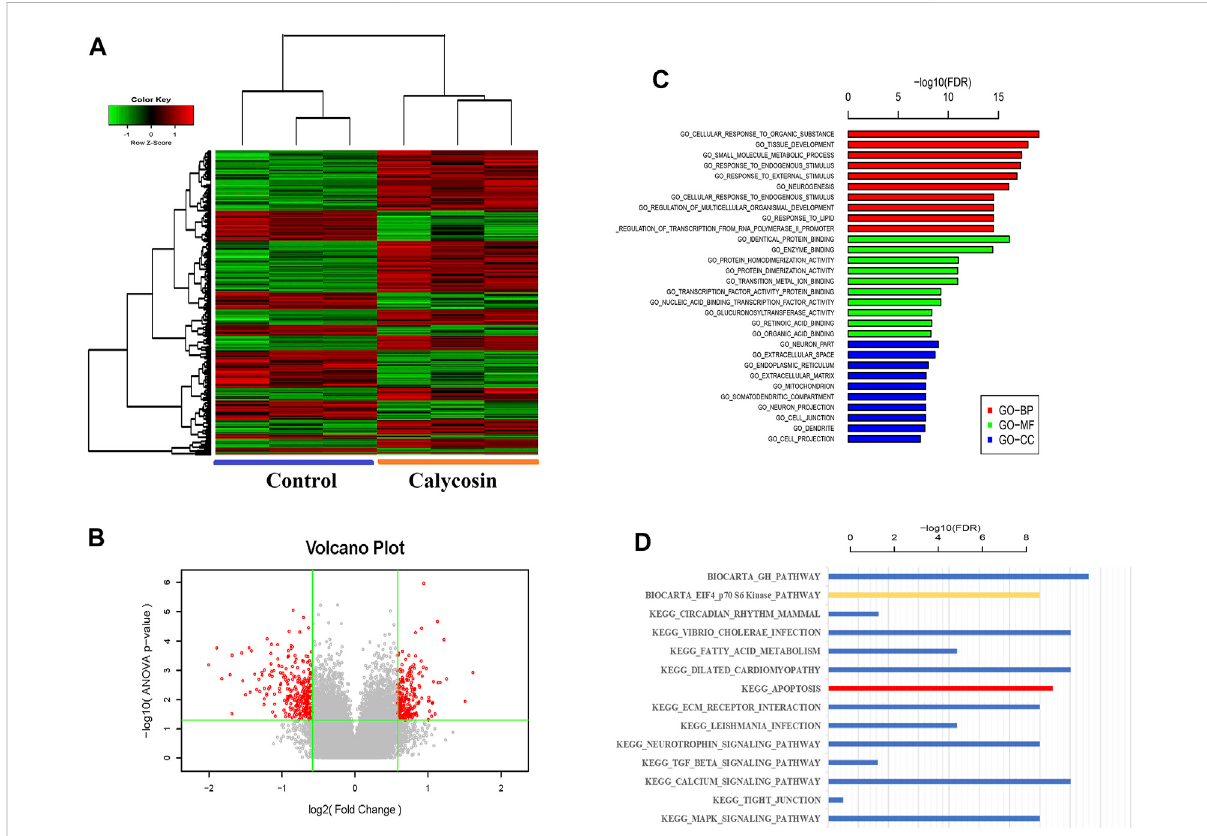
FIGURE 3 Whole Transcriptome Microarray Bioinformatics Analysis. (A) The DEGs of B-CPAP cells were treated with calycosin (0.100 µM) for 24 h. DEG screening criteriawere: |Fold Change| ≥ 1.5and p -value < 0.05. (B) Volcanoplot:thereddots arepoints with|Fold Change| ≥ 1.5and p -value < 0.05isa signi fi cantdifferencegeneforstandardscreening,andthegraypointsareothergeneswithnosigni fi cantdifference. (C) TheGOtermswiththemost signi fi cant DEG enrichment are listed. (D) The pathways with the most signi fi cant enrichment of KEGG in DEGs are listed.